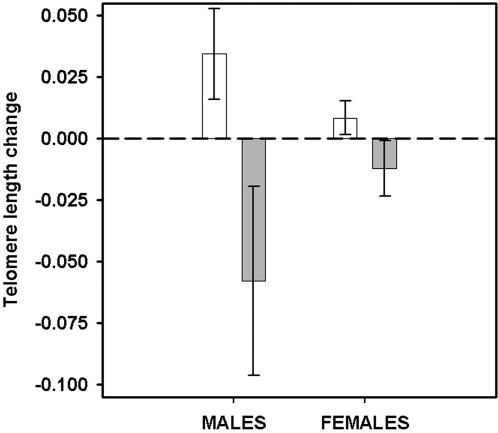
The consequences of infection on telomere length.Change of telomere length (mean±s.e.m.) of WBCs from sham-infected controls (white bars) versus infected mice that still harboured Salmonella at termination (grey bars). Negative values indicate telomere attrition and positive values telomeric gain.